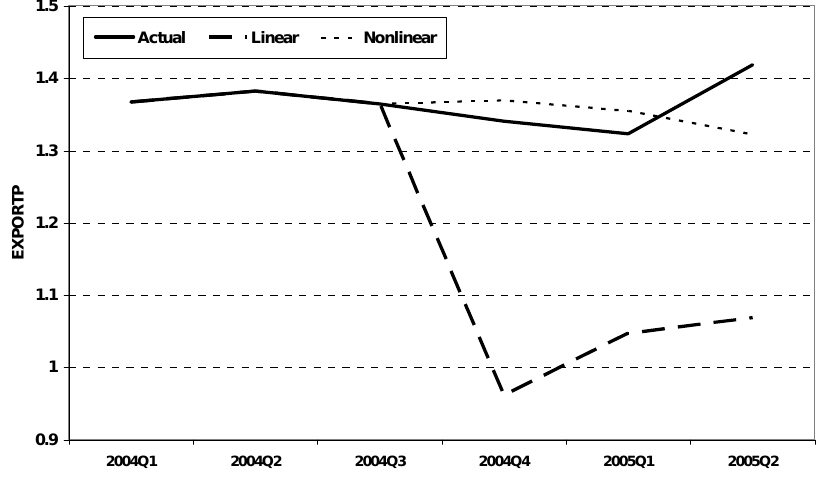
FIGURE 3: Actual data vs. linear model vs. non-linear model (EXPORTP)